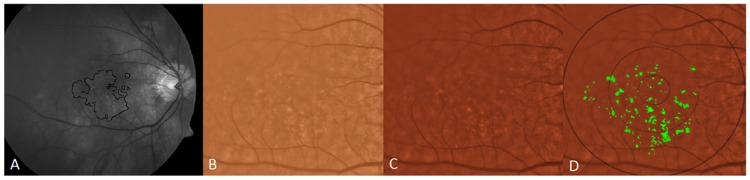
Illustration of drusen segmentation methods.A) Red-free fundus photo. Areas with drusen are circled in black (human supervision) to initialize the segmentation program. This allows the program to exclude from consideration peripapillary changes and other hypo-pigmented or hyper-reflective non-drusen features, resulting in a more rapid and accurate drusen identification. B) original color fundus photograph, cropped to 6 mm field C) contrast-enhanced color photograph D) contrast-enhanced color photograph with superimposed Wisconsin grading template (6 mm diameter circle with central, middle and outer subfields of diameters of 1, 3 and 6 mm). Drusen have been automatically segmented in detail (green) by the custom software within the areas containing drusen identified in A.